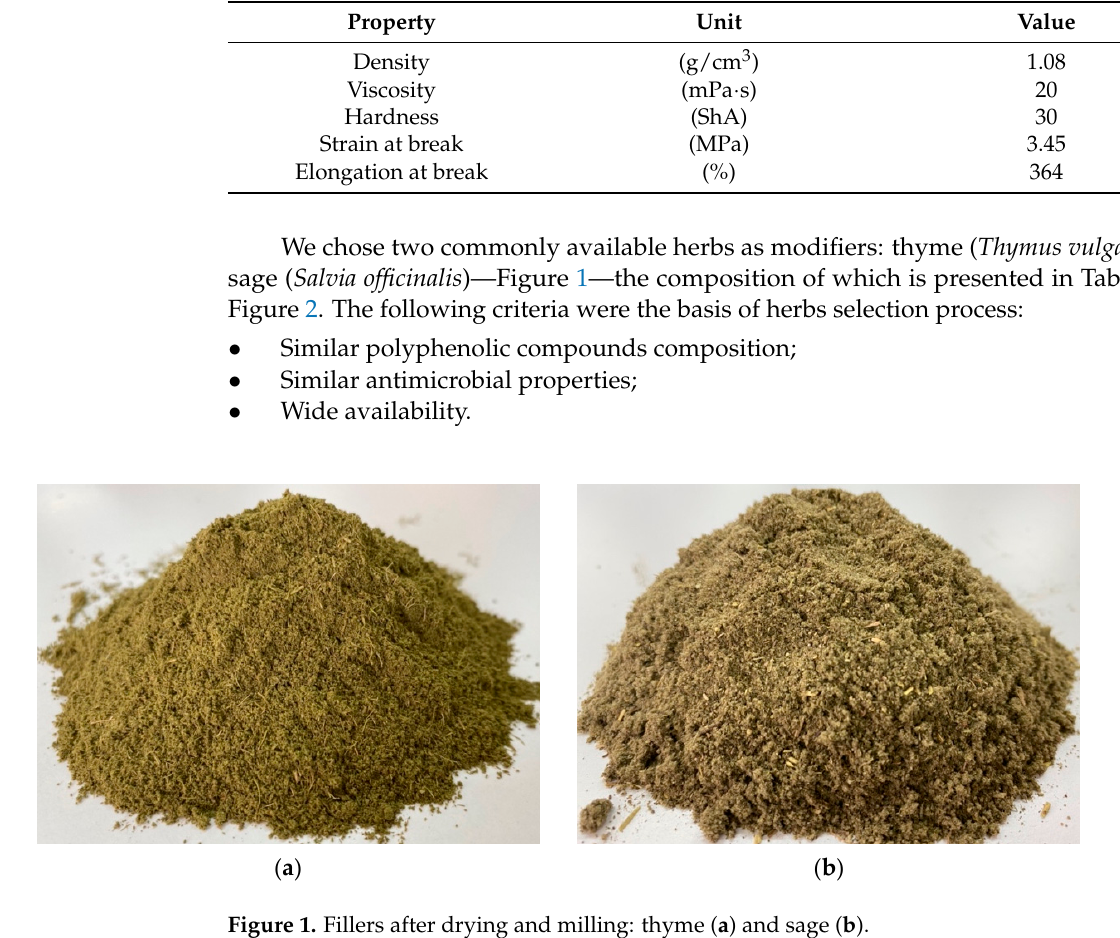
Table 1. Silicone properties [36].